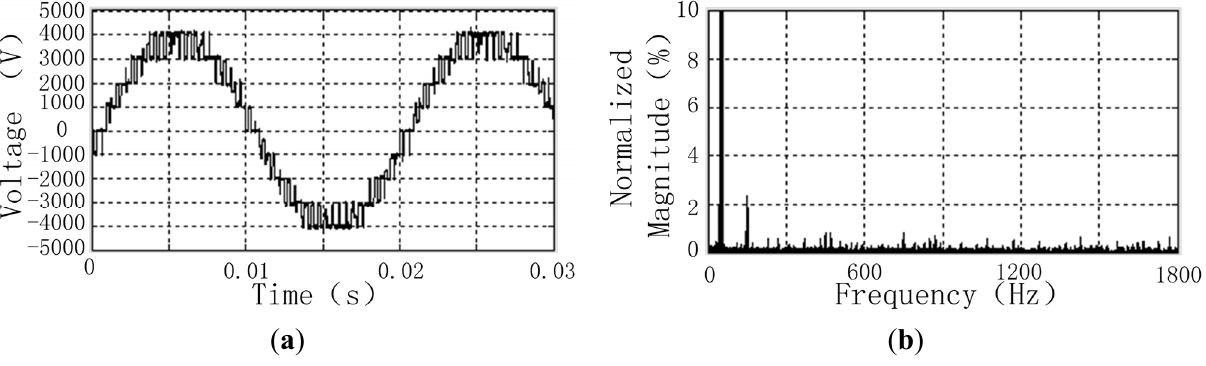
Figure 10. Result of the proposed PSCPWM when the second cell dc voltage is 395 V: ( a ) output voltage waveform; and ( b ) harmonics.